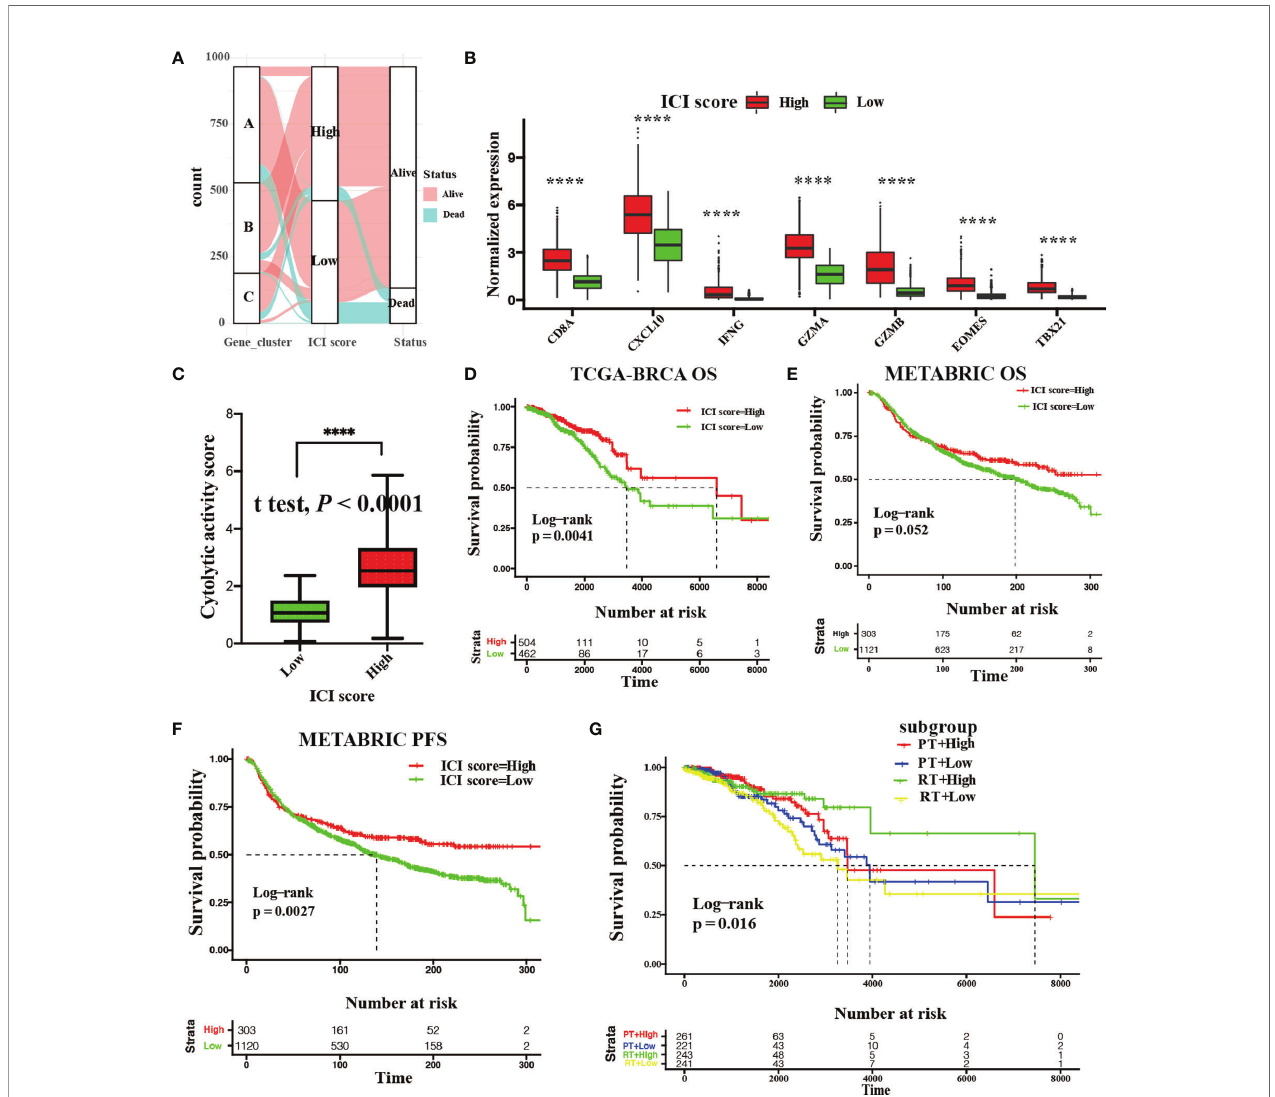
FIGURE 4 | Development and validation with the ICI score. (A) Gene phenotype distribution of the ICI score and clinical outcomes. (B) Gene expression levels of effector T-cell in fi ltration (CD8A and CXCL10) and INF- g -related cytotoxicity (IFNG, GZMA, GZMB, EOMES, and TBX21) between the high and low ICI score group. (Wilcoxon test **** P < 0.0001). (C) The cytolytic activity score between the high and low ICI score groups. (Student ’ s t test, **** P < 0.0001). (D) Kaplan – Meier curve showing OS outcomes between the high and low ICI score groups in the TCGA-BRCA cohort. Log-rank test showing P = 0.0041. (E, F) Kaplan – Meier curve showing OS outcomes ( E ; log-rank test, P = 0.052) and PFS outcomes ( F ; log-rank test, P = 0.0027.) with BRCA patients between the high and low ICI score groups in METABRIC cohort. (G) Kaplan – Meier curve showing OS outcomes of BRCA patients between the high and low ICI score groups treated with radiotherapy (RT) or chemotherapy (CT) in the TCGA-BRCA cohort (log-rank test, P =